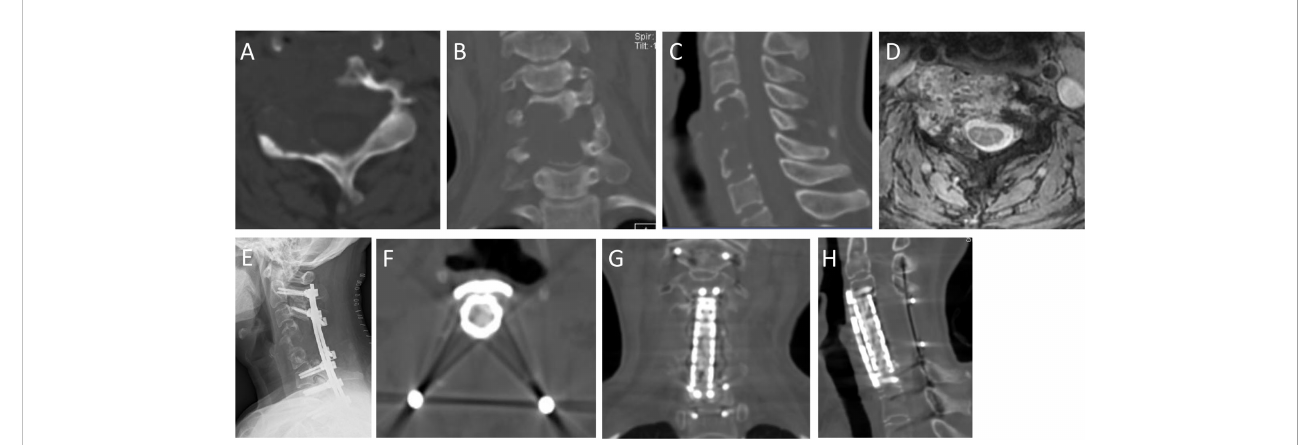
FIGURE 6 A 47-year-old female with neck pain for 12 months, accompanied with pain and numbness of left upper extremity for the recent 1 month. Preoperative imaging examination showed an osteolytic lesion was in the C4-6. She underwent GTR (piecemeal spondylectomy). At 62-month follow-up, she was symptom free. (A,B,C) : Preoperative axial, coronal and sagittal CT scans; (D) : T2-weighted axial MRI scans; (E) : Postoperative X-ray; (F – H) : Axial, coronary and sagittal CT scans in 62th month after